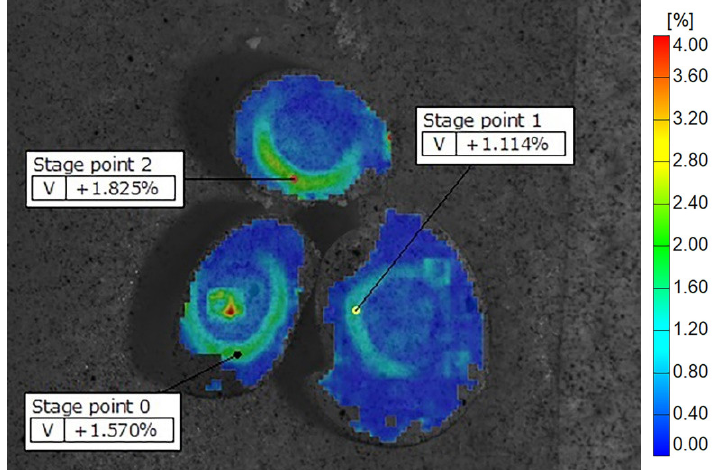
Figure 4. Display of MTA deformation fields across the samples on dentine discs, showing peripheral zones with higher and central zones with lower strain values. The color scale indicates different strain values, with the highest marked in red and orange. Some of the recorded reference points are shown as stage points 0, 1 and 2.